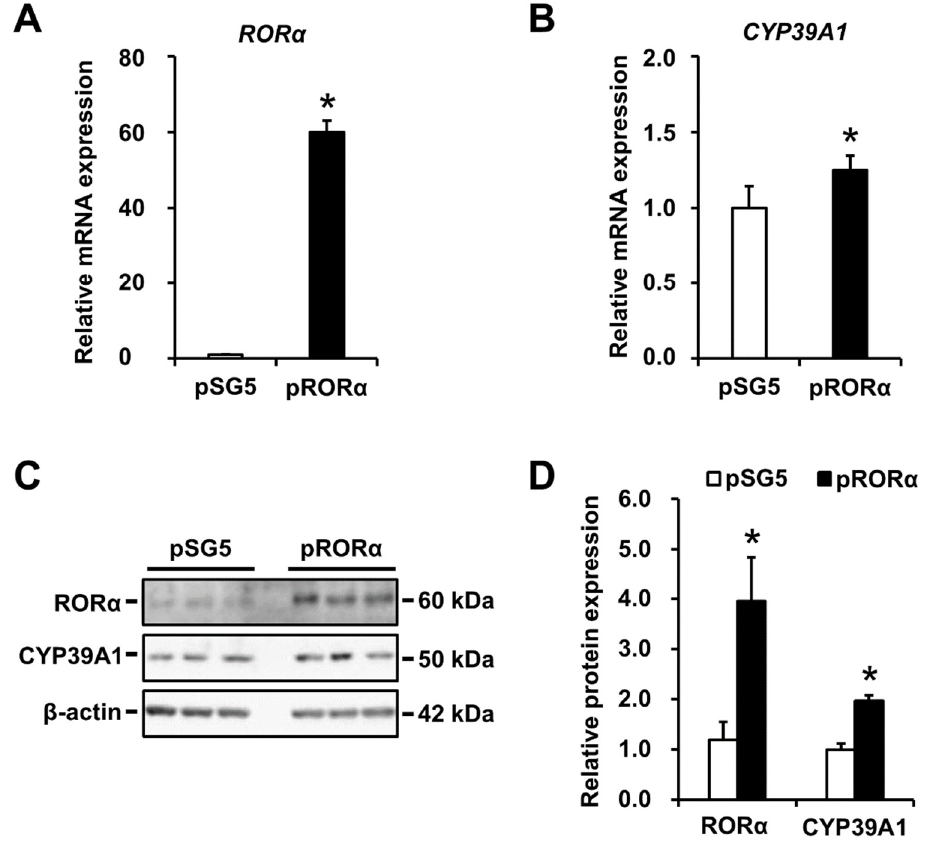
Figure 3. Regulation of endogenous CYP39A1 expression by RORα overexpression. RORα expression (pRORα) and empty vectors (pSG5) were transfected into HEK293 cells at 48 h; the expression of RORα ( A ) and CYP39A1 ( B ) mRNA transcripts were measured using qRT-PCR. ( C ) pRORα and pSG5 vectors were transfected into HEK293 cells at 72 h; the expression of RORα and CYP39A1 proteins were measured by western blot analysis. ( D ) Densitometric analysis of protein bands from RORα overexpression experiments quantified using a CS analyzer software. Data are presented as means ± standard error of the means ( n = 3). *, p <